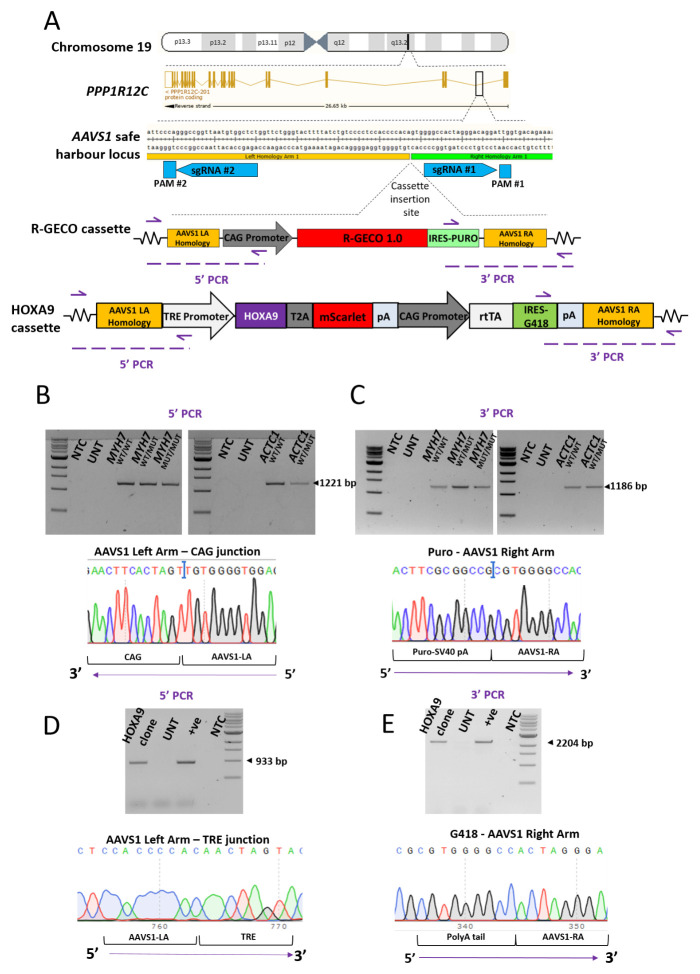
Generation of
AAVS1-targeted hiPSC clones in an isogenic
MYH7 C9123T background and an isogenic
ACTC1 G301A background.(
A) Schematic illustrating the chromosomal location of the
AAVS1 safe harbour locus. This site was targeted using two sgRNAs in a CRISPR Cas9 nickase strategy. PAM site #1 was silently mutated (G→C) in the targeting construct to prevent it being cut by Cas9 nuclease during targeting. The inserted cassette consists of R-GECO1.0 IRES-Puromycin driven by the CAG promoter. This is flanked on each side by 1 kb of homology to the
AAVS1 locus. In (
B) and (
C) confirmatory 5’ and 3’ targeting PCR screen is shown using genomic DNA isolated from the
MYH7 C9123T RGECO1.0 isogenic trio (left) and the
ACTC1 G301A RGECO duo (right) hiPSCs. Correct 5’ targeting is indicated with a 1221bp product, with sequencing confirming the fidelity of the junction between the
AAVS1 left arm homology and the start of the CAG promoter. Correct 3’ targeting is indicated with an 1186bp product, with sequencing confirming the fidelity of the junction between the puromycin-SV40 pA sequence and the
AAVS1 right arm homology. (
D,
E) Confirmatory PCR and sequencing of hiPSC clones to check 5’ and 3’ targeting of the
AAVS1 locus with the HOXA9-T2A-mScarlet cassette.